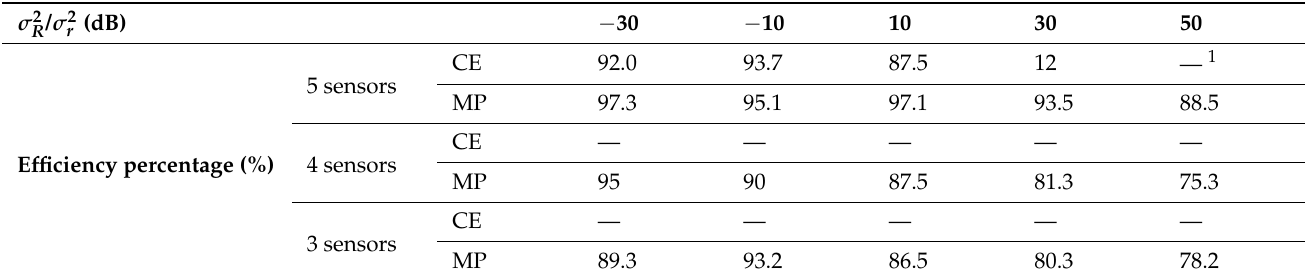
Table 5. Efficiency percentage of the CE and MP methods (Simulation